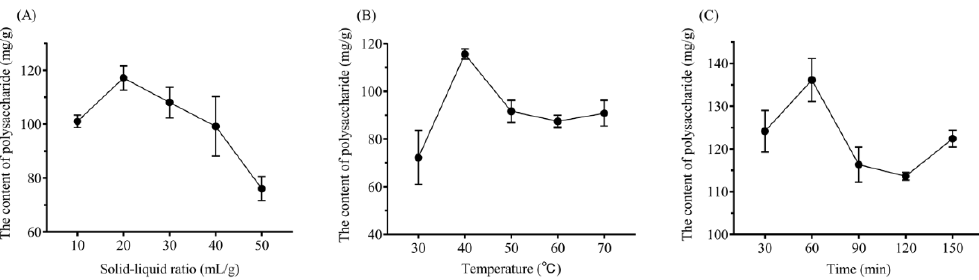
Figure 1. E ff ects of di ff erent extraction parameters on the yield of polysaccharides. ( A ) liquid-solid ratio, ( B ) extraction temperature and ( C ) extraction